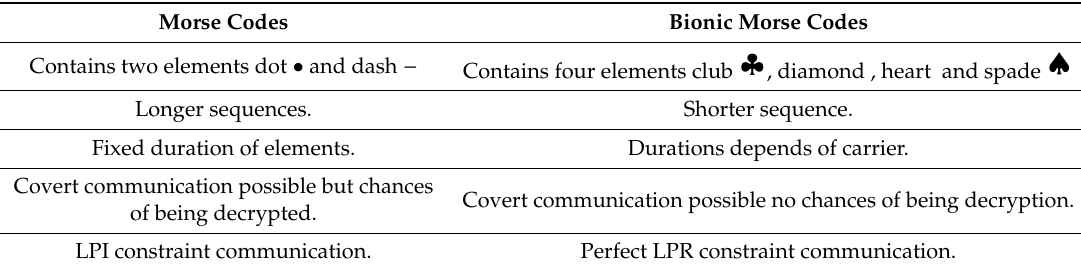
Table 2. Comparison of Morse Codes and bionic Morse Codes.